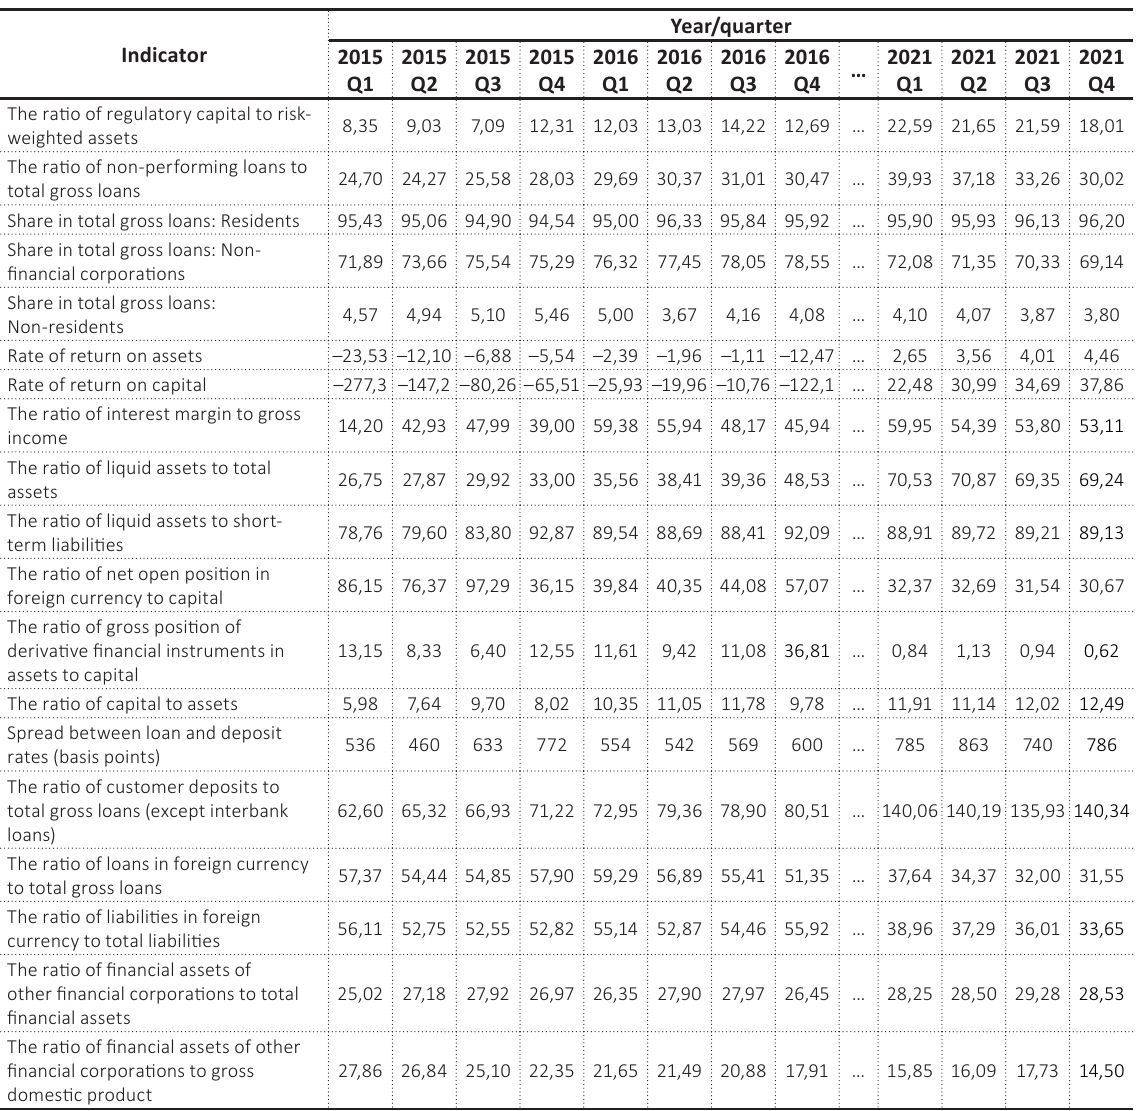
Table А1. Information base for the study of the financial sector security in Ukraine Indicator